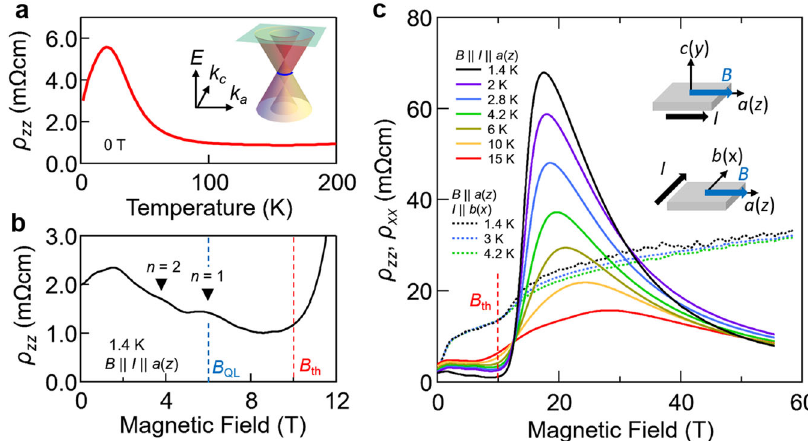
Fig. 1 Giant magnetoresistance in the quantum limit of Dirac electrons. a Temperature dependence of the resistivity. The inset is a schematic illustration of energy dispersion in k a − k c plane near the line node (blue line) near the Fermi energy (pale green plane). b Shubnikov-de-Haas (SdH) oscillations in magnetoresistivity in the longitudinal con fi guration ( B || I || a ( z )). B QL and B th correspond to the magnetic fi eld where quantum limit is reached and where the MR starts to increase steeply. c , Magnetoresistivity in the longitudinal con fi guration ( B || I || a ( z )) at various temperatures. Magnetoresistivity in the transverse con fi guration ( B || a ( z ), I || b ( x )) at several temperatures is also shown as dotted line. We used two different samples for the longitudinal and transverse con fi gurations but they have almost the same carrier density [see Supplementary Note